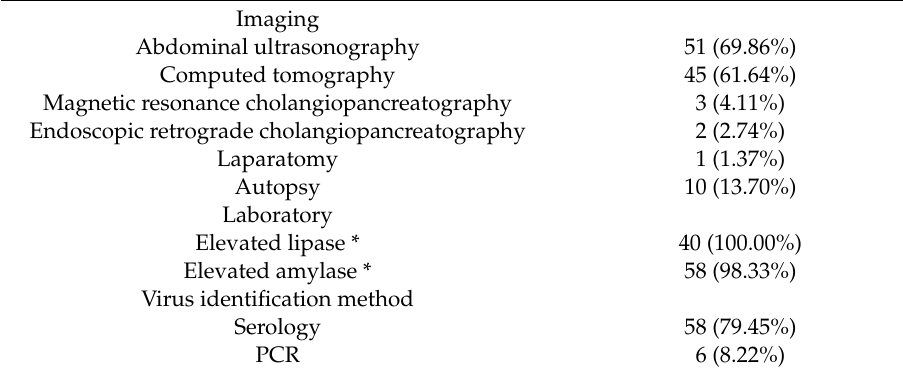
Table 3. Diagnostics in 73 patients with viral hepatitis diagnosed with